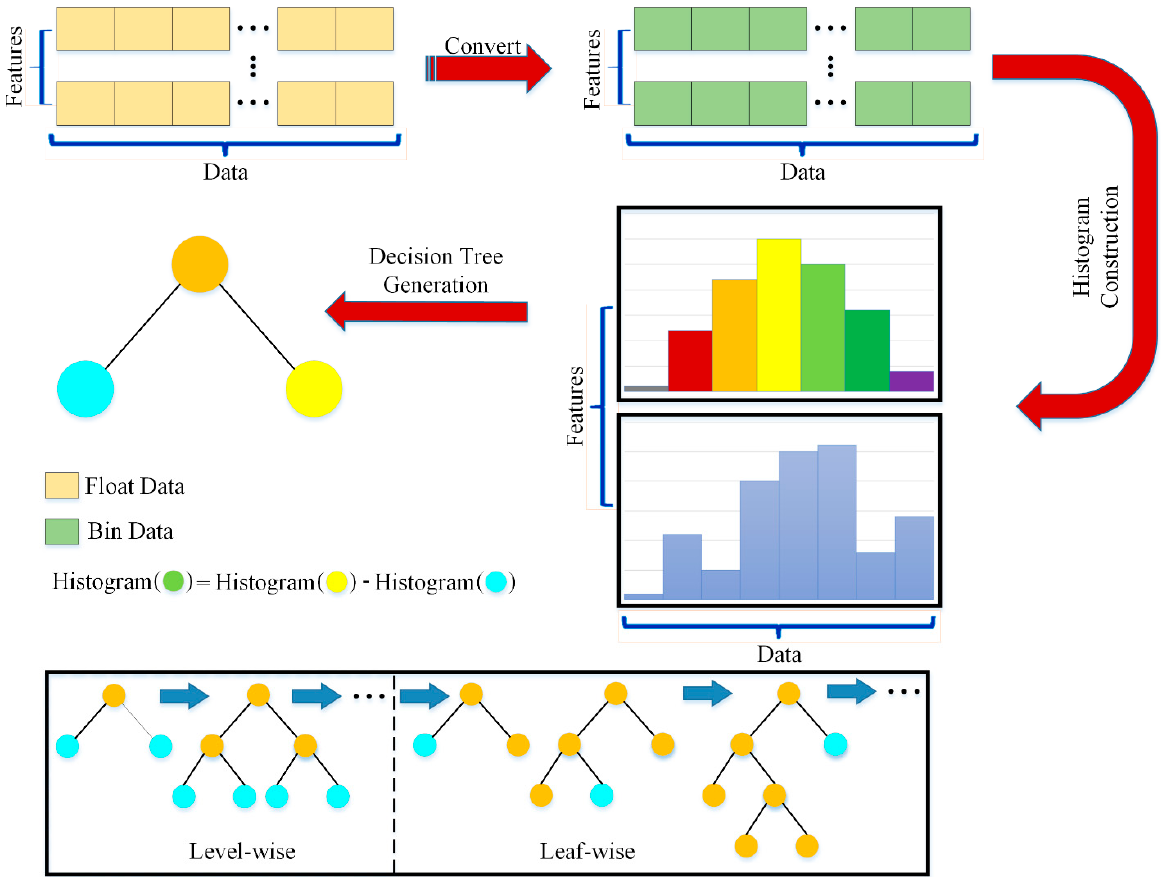
Figure 4. Illustration of 𝐿𝑖𝑔ℎ𝑡𝐺𝐵𝑀 algorithm.